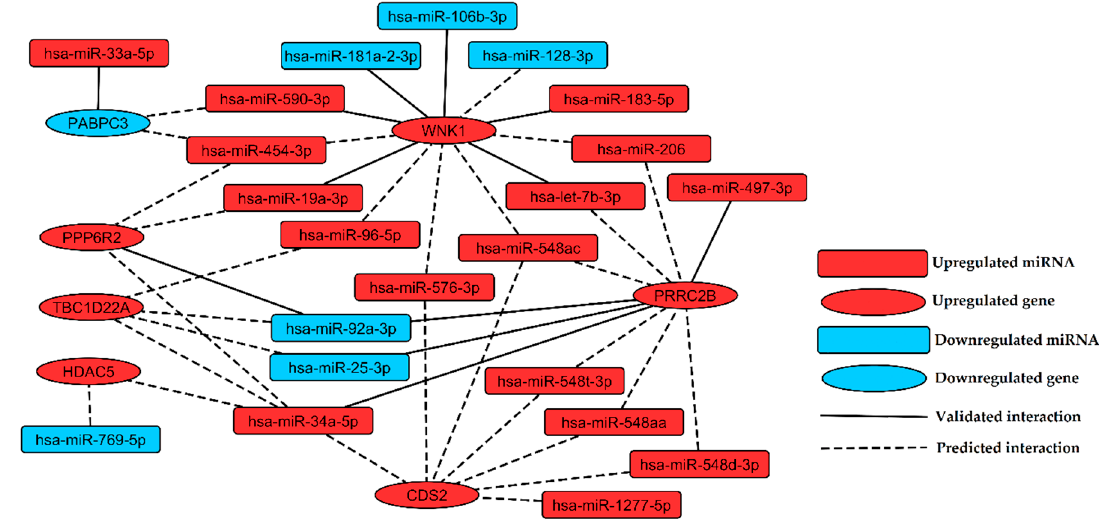
Figure 4. Regulatory network of interactions found in silico between miRNAs and genes indicated as the most promising biomarkers of chronic venous disease. Upregulated and downregulated nodes (miRNAs or genes) were labeled with red and blue color, respectively. Validated and predictive interactions were labeled with solid and dashed edges, respectively.